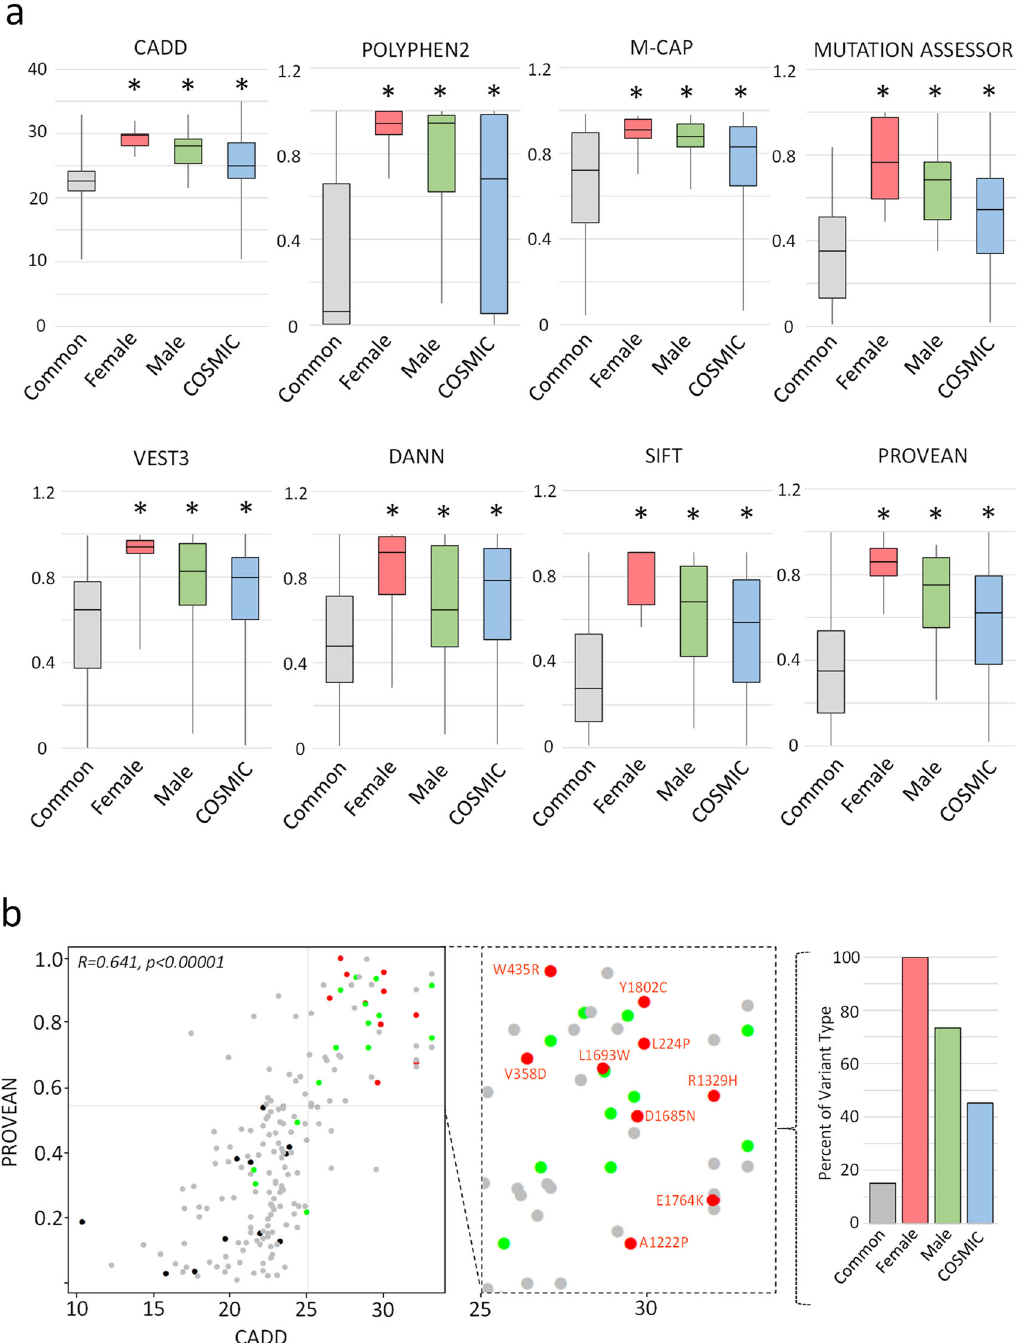
Fig. 2 USP9X -female missense variants display in silico signatures of pathogenicity. a Aggregate comparison of common variants extracted from gnomAD (allele frequency >1:100000), against females missense variants, likely pathogenic male missense variants, and variants found in cancer (extracted from COSMIC database) using a suite of in silico prediction tools. Box-whisker plots are de fi ned as follows: centre line, median; box limits, upper and lower quartiles; whiskers, min and max values. *signi fi cantly different from common variants p < 0.05 by two- tailed equal variance Student ’ s t -test. b Comparison of CADD and PROVEAN scores reveal clustering of variants all female missense variants in the upper-right quadrant consistent with pathogenicity (CADD > 25, PROVEAN > 0.565). Scores of common variants are signi fi cantly correlated (Pearson ’ s correlation given). Colour scheme as in a . Inset identi fi es each variant in the ‘ pathogenic quadrant ’ . Graphs show percent of each type of variant, and the overall composition of variant types within the pathogenic